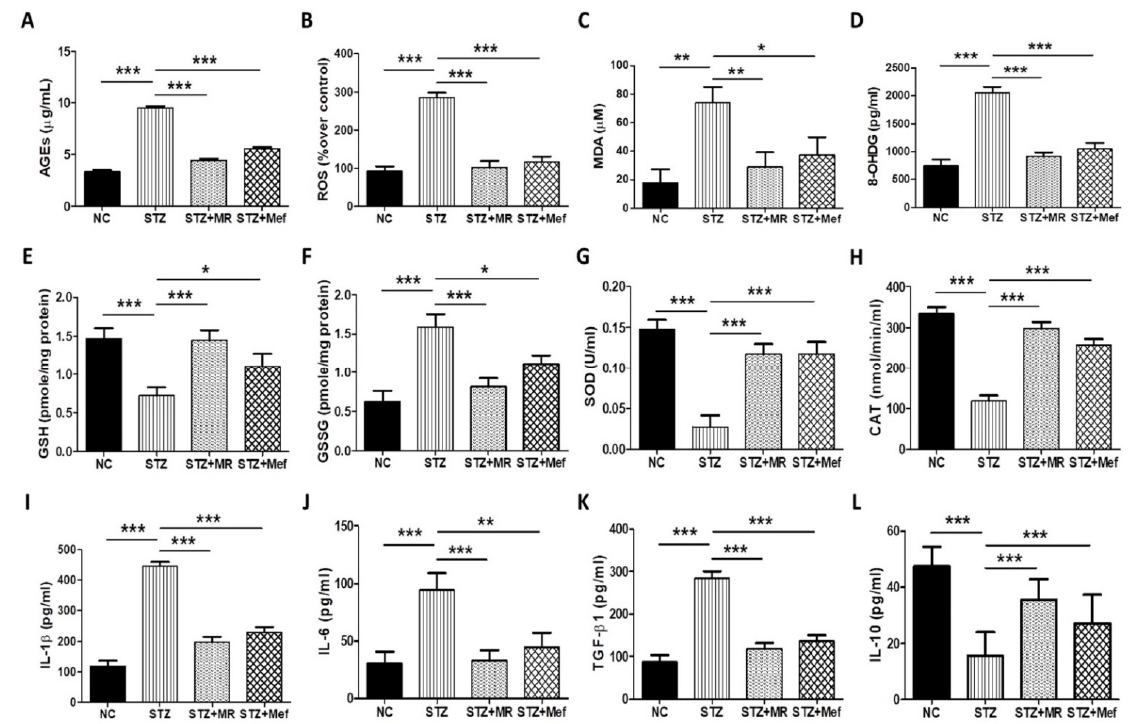
Figure 3. Effects of MR extract on oxidative and inflammatory stress in STZ-treated rats. Levels of ( A ) AGEs, ( B ) intracellular ROS, ( C ) MDA, and ( D ) the oxidative DNA damage marker (8-OHdG) were measured in the kidneys of diabetic animals. ( E – H ) Variations in oxidative biomarkers (GSH, GSSG, SOD, and CAT) were evaluated in the kidneys of diabetic animals. Data are expressed as